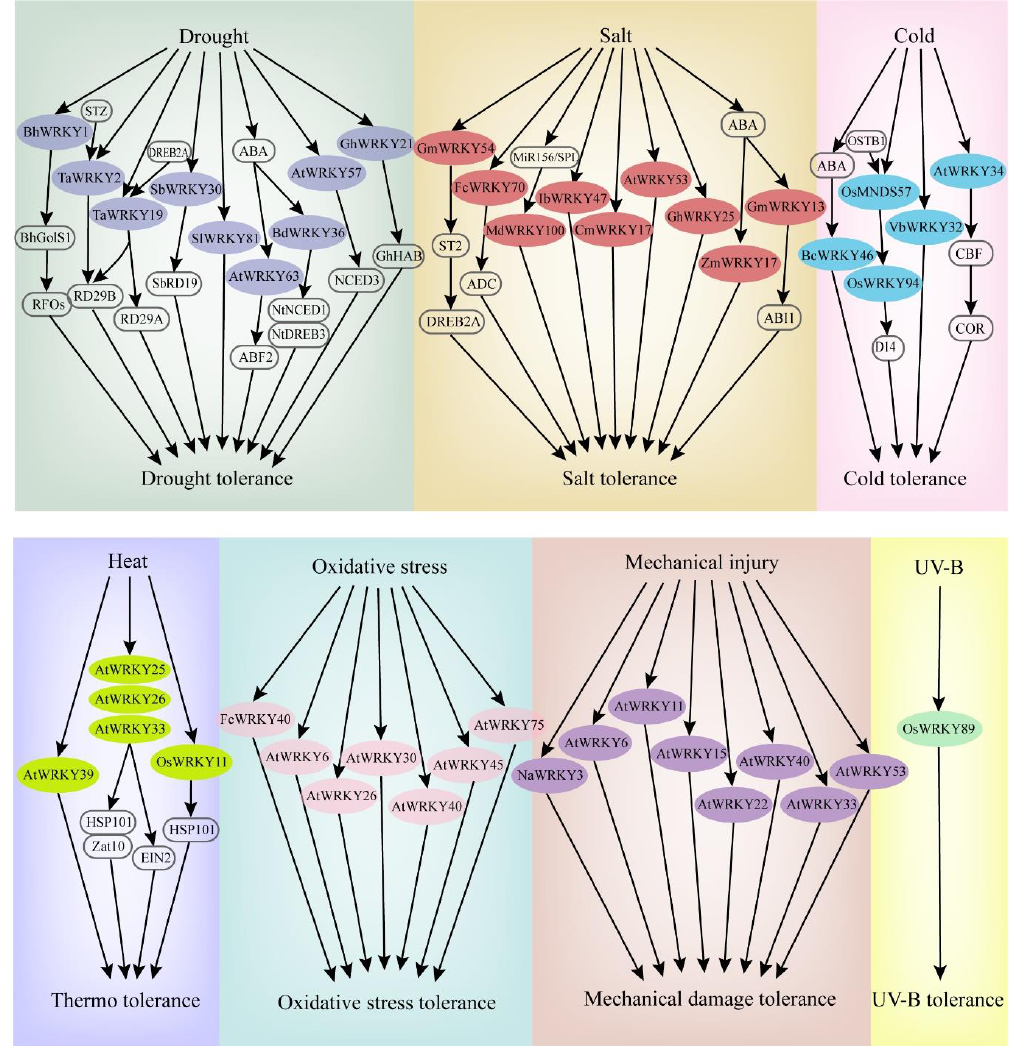
Figure 2. Some WRKY genes involved in the response pathways of major abiotic stresses (drought, salt, cold, heat, oxidative stress, mechanical injury, UV-B). cold, heat, oxidative stress, mechanical injury,